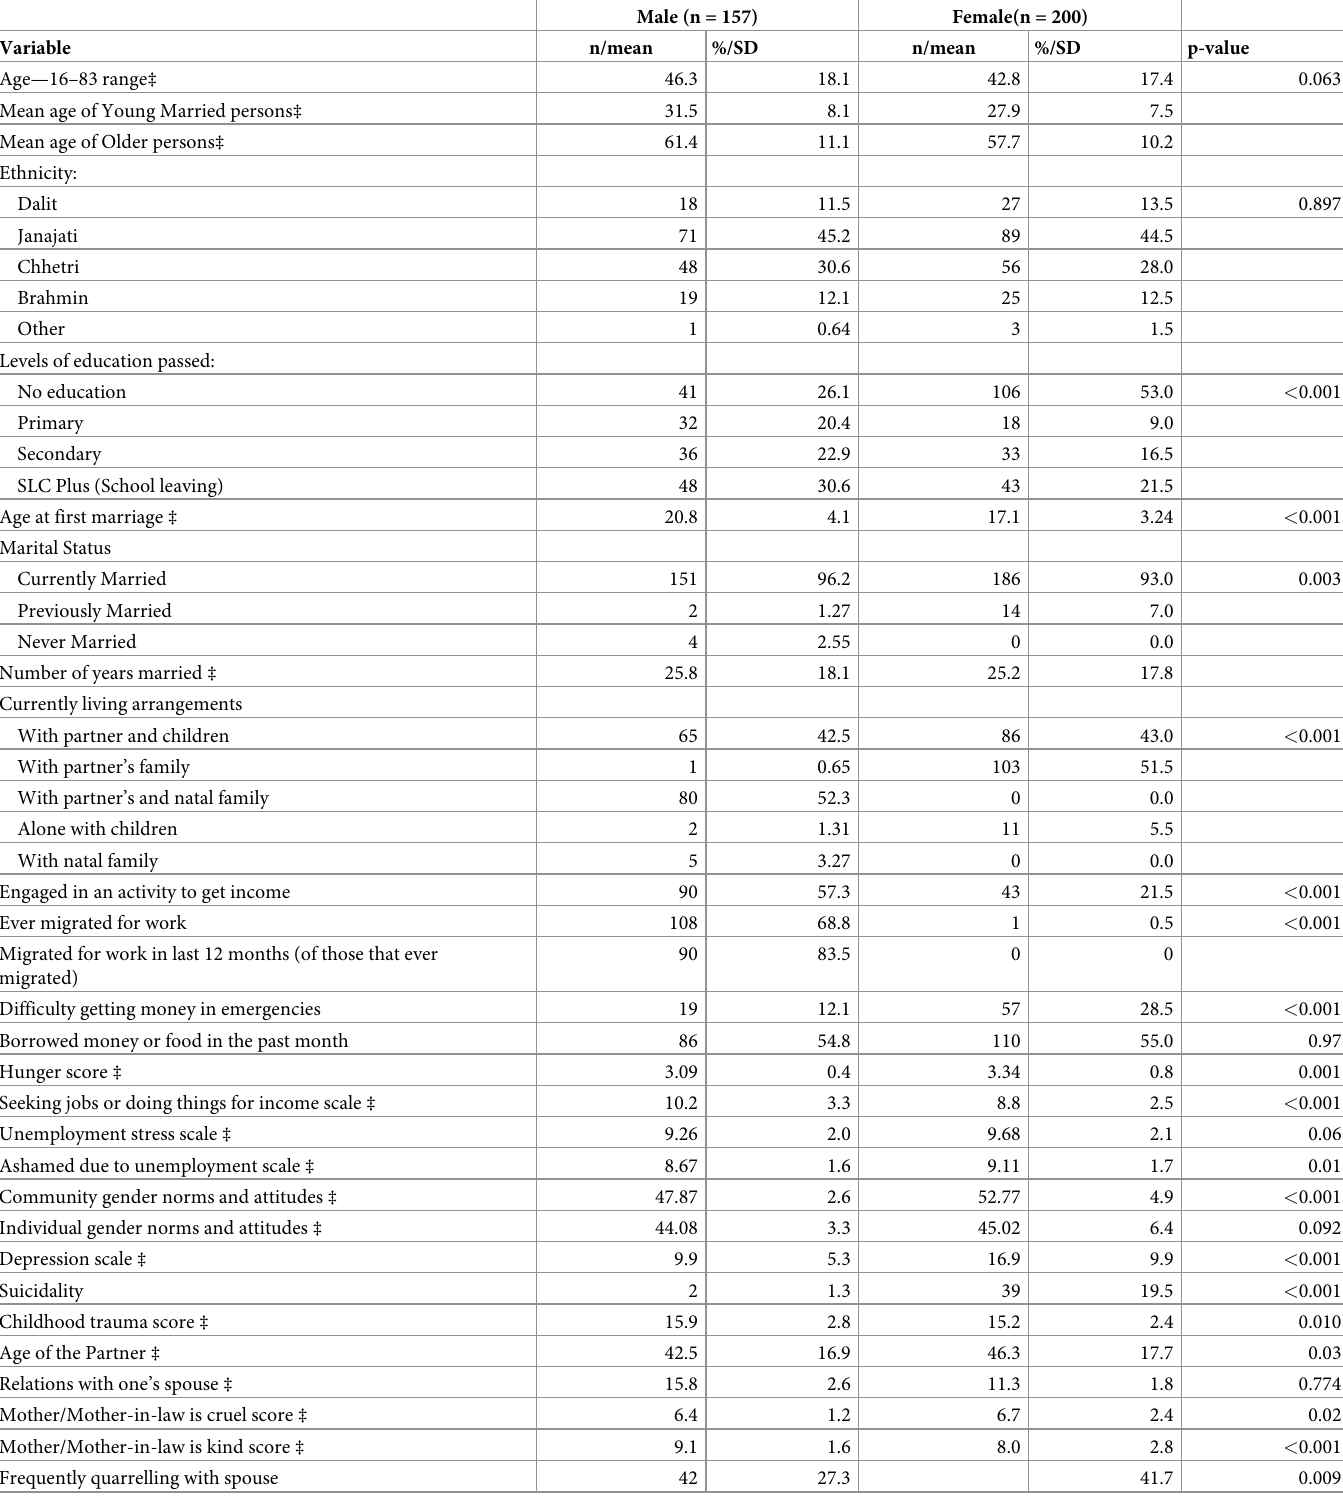
Table 1. Social and demographic background of men and